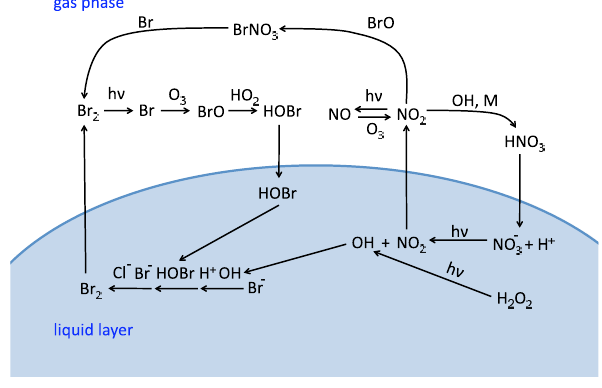
Fig. 2. Chemical pathways important for NO x and reactive bromine cycling at Summit,